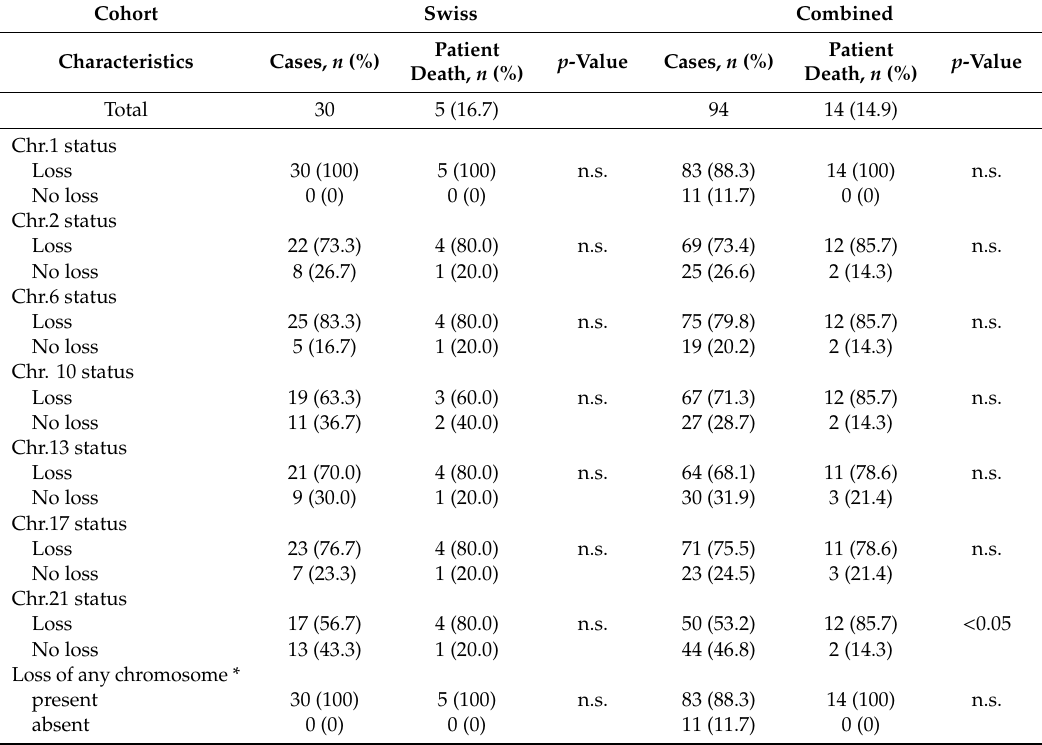
Table 4. Univariate survival analysis (Kaplan-Meier) with log-rank test (overall survival) of 94 chRCC patients combined from Swiss and TCGA-KICH cohorts (Chr. = chromosome). Cohort Swiss